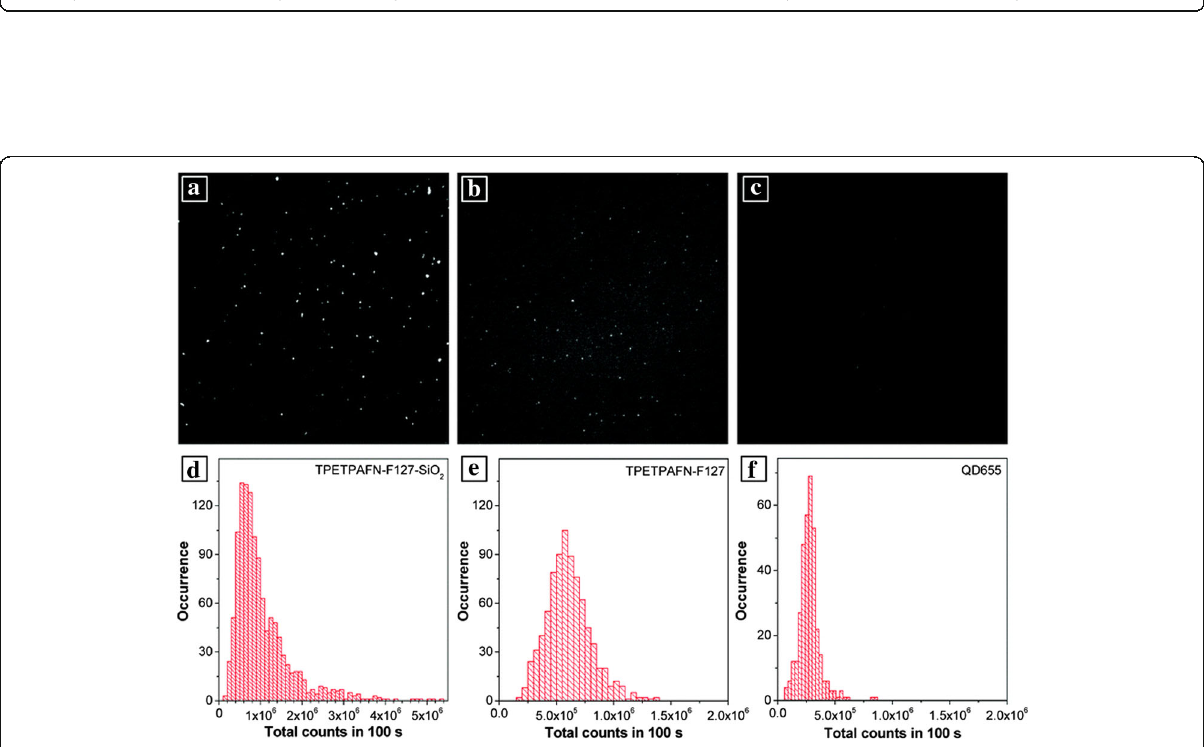
Fig. 3 a , d Showing the images of fluorescence and the histograms of photons of TPETPAFN-F127-SiO 2 NPs, corresponding b , e for TPETOAFN NPs and c , f for commercial QD655